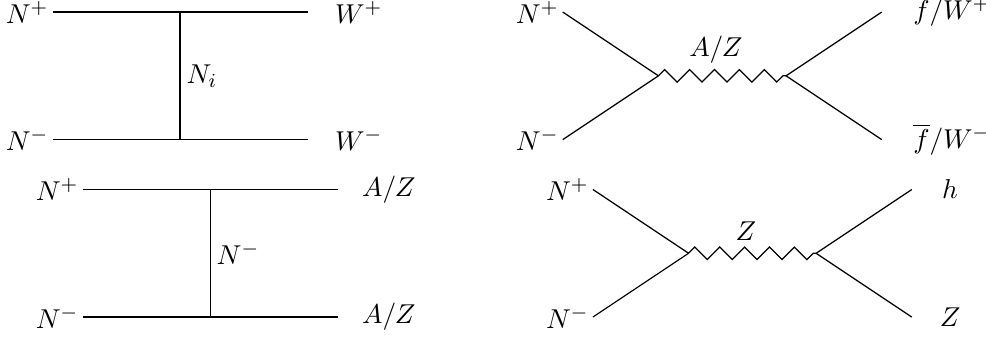
Figure 25 . Co-Annihilation process of charged fermions N (cid:6) to SM particles in (cid:12)nal